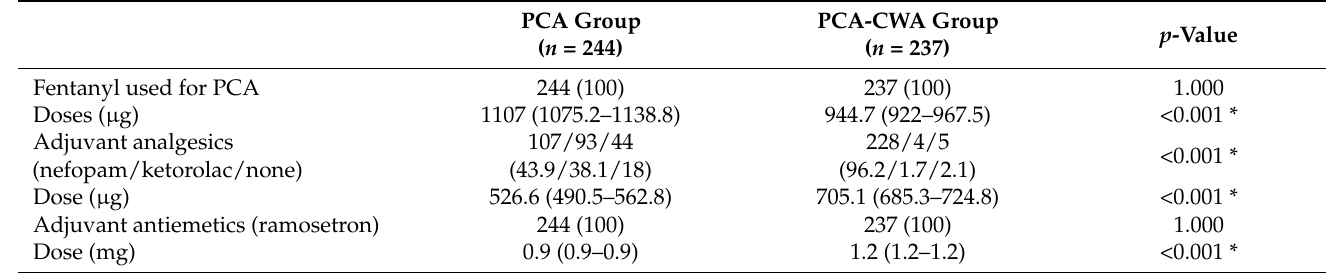
Table 3. Postoperative analgesia modalities before propensity score matching.